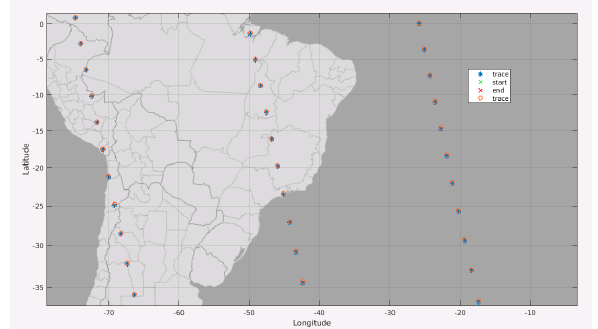
Figure 15. Zoom on Figure 14 showing the positioning of the ALOS-2 satellite during data acquisition in the area of interest